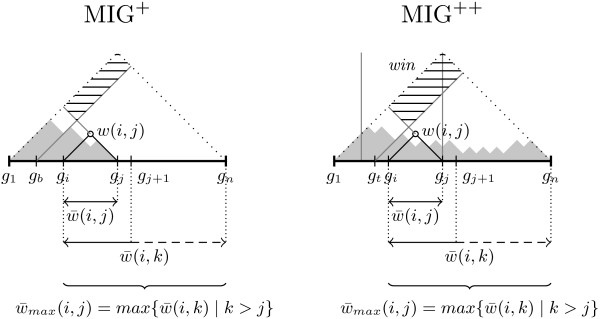
Processing a chromosome with MIG+ and MIG++.w¯max(i,j) is computed taking into account the SNP-pair weights computed at the previous stages (colored in gray). MIG +: since w¯max(i,j)<0 for any region that starts before the SNP gb and ends after the SNP gj, then the SNP-pair weights within the hatched area are omitted from computation. MIG ++: the SNP-pair weights within the hatched area are omitted from computation if w¯max(i,j)<0 for any region that starts before the SNP gt and ends after the SNP gj, or gt is out of the window win (in the latter case the omitted SNP-pair weights may be used in the next iteration).